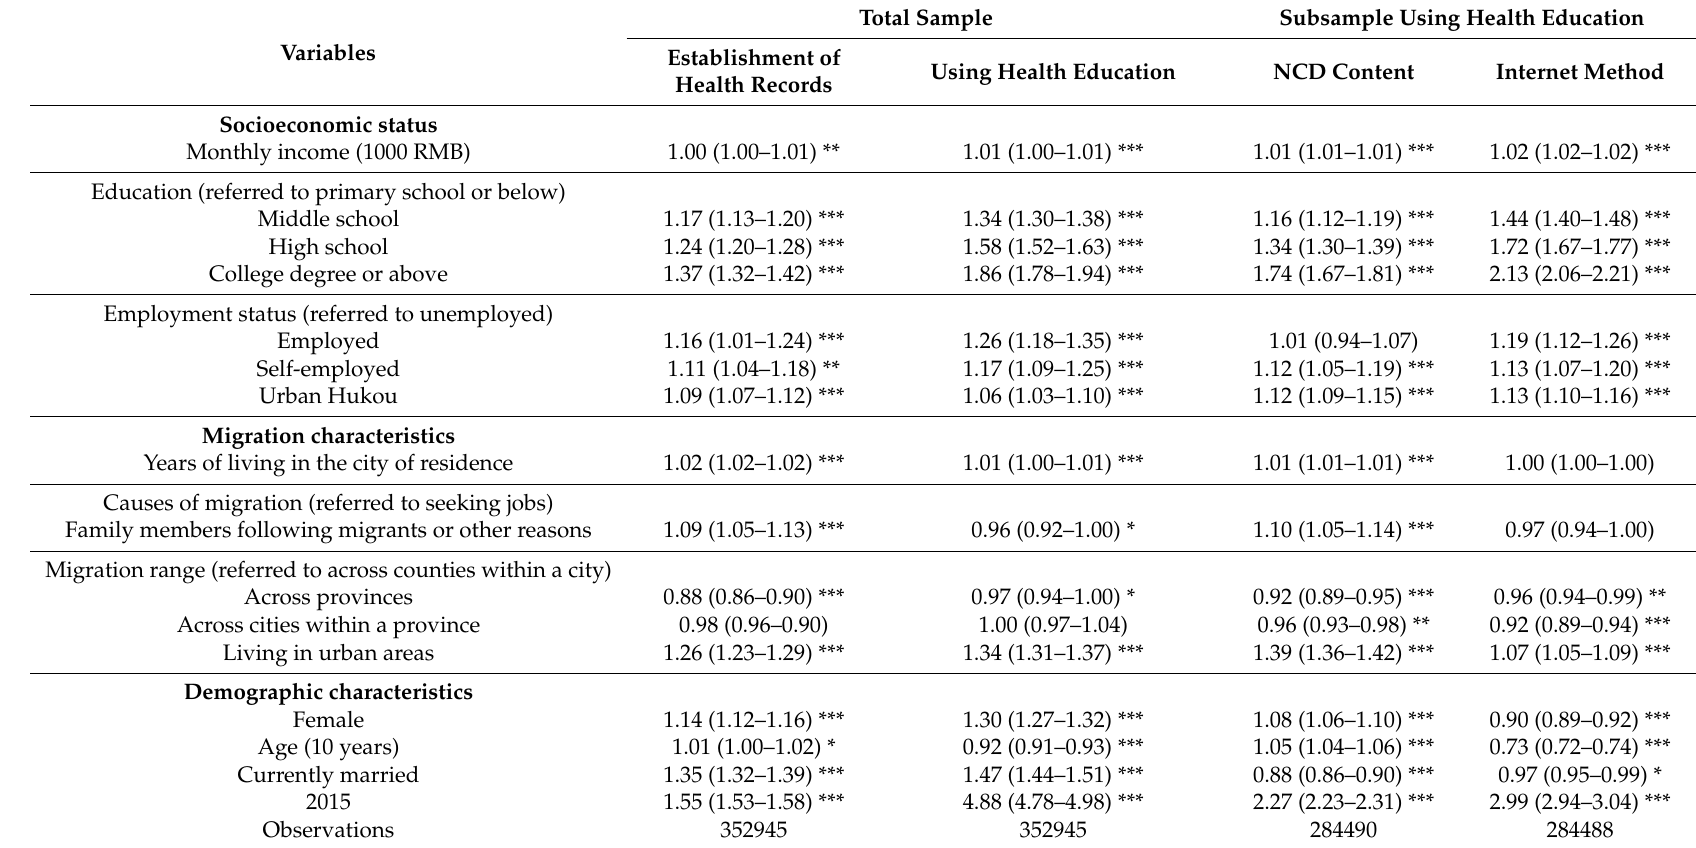
Table 3. Determinants of local public health services utilization, the contents and channels of health